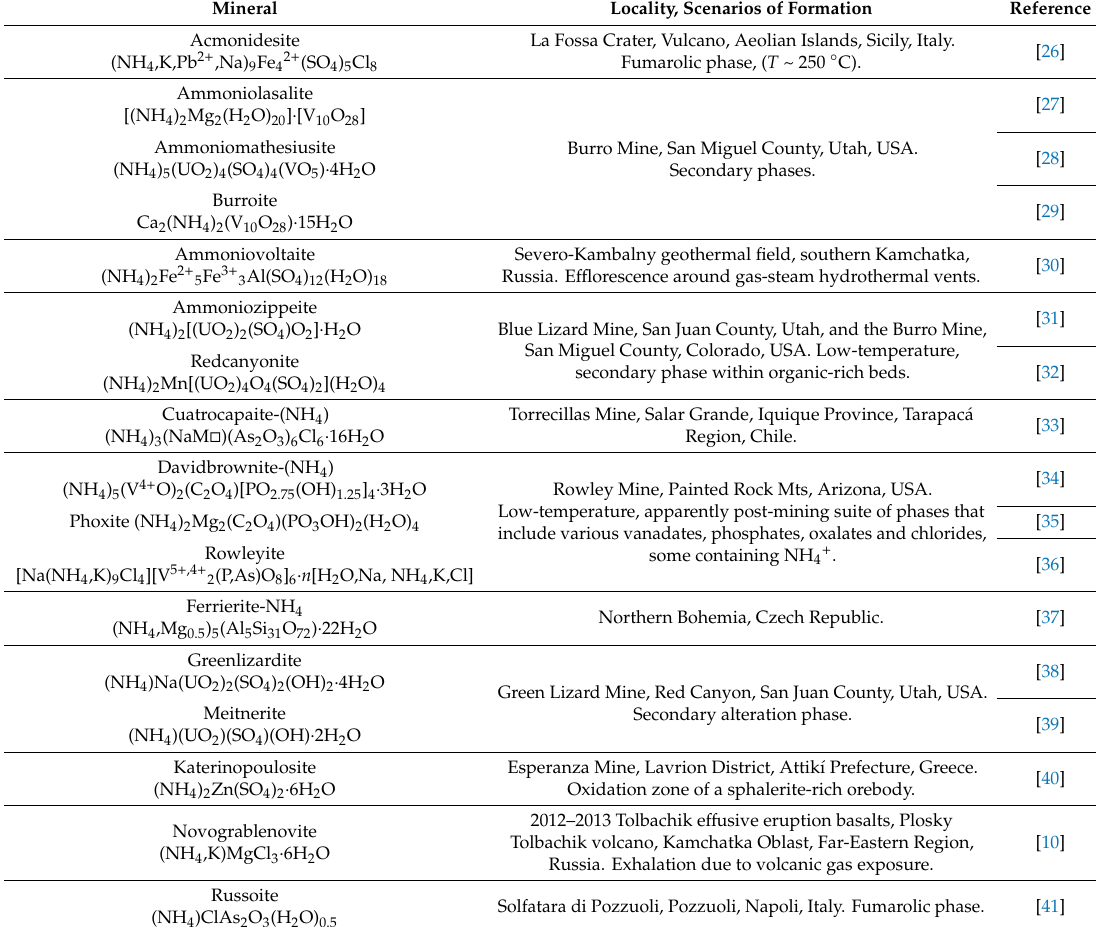
Table 1. Recently discovered ammonium